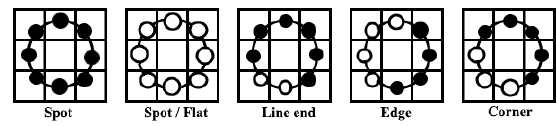
Figure 2. Different texture primitives detected by LPB u 2